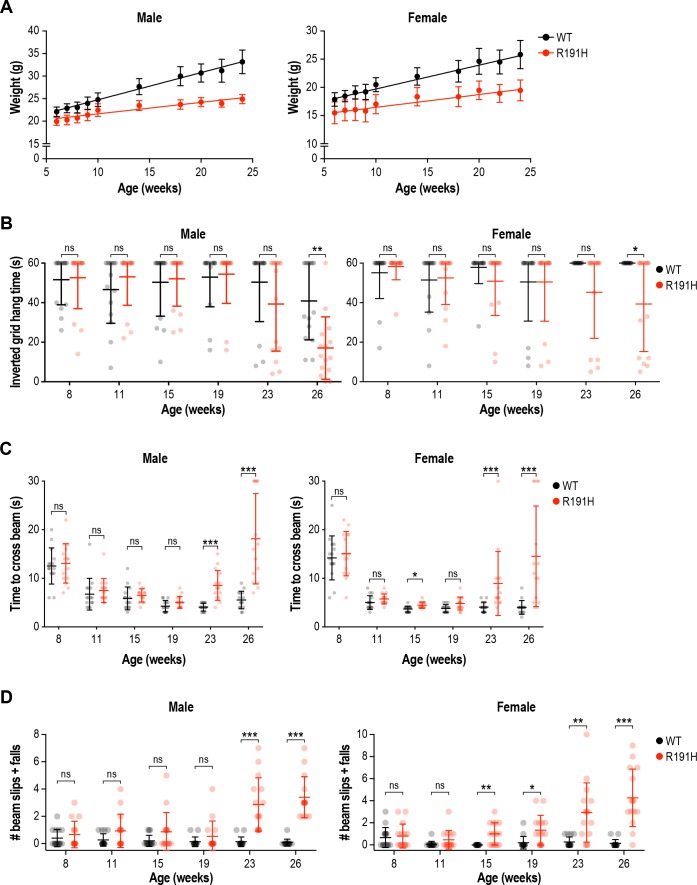
R191H mice exhibited reduced body weight and age-dependent performance impairment in motor assays.(A) Body weight measurements along the study. Lines are linear regressions. 5-week-old R191H mice had significantly lower body weight compared to WT littermates, and the weight difference persisted as animals aged. In both males and females, weights were significantly different at all time points (p<0.01; two-way ANOVA with Holm-Sidak pairwise comparisons). (B) Inverted grid test of grip strength. At week 26, the difference in hang time between WT and R191H was statistically significant. (C–D) Beam-crossing assay to measure motor coordination. Motor deficits were not evident in R191H mice at early time points (8–19 weeks), but became apparent in older animals (23 and 26 weeks). At the later time points, R191H animals took significantly longer to cross the beam (C) and suffered more slips and falls while crossing (D). For all panels, n = 15/genotype were analyzed. Error bars are SD. *p<0.05; **p<0.01; ***p<10-3; nsp>0.05 by Mann-Whitney test with Bonferroni correction.